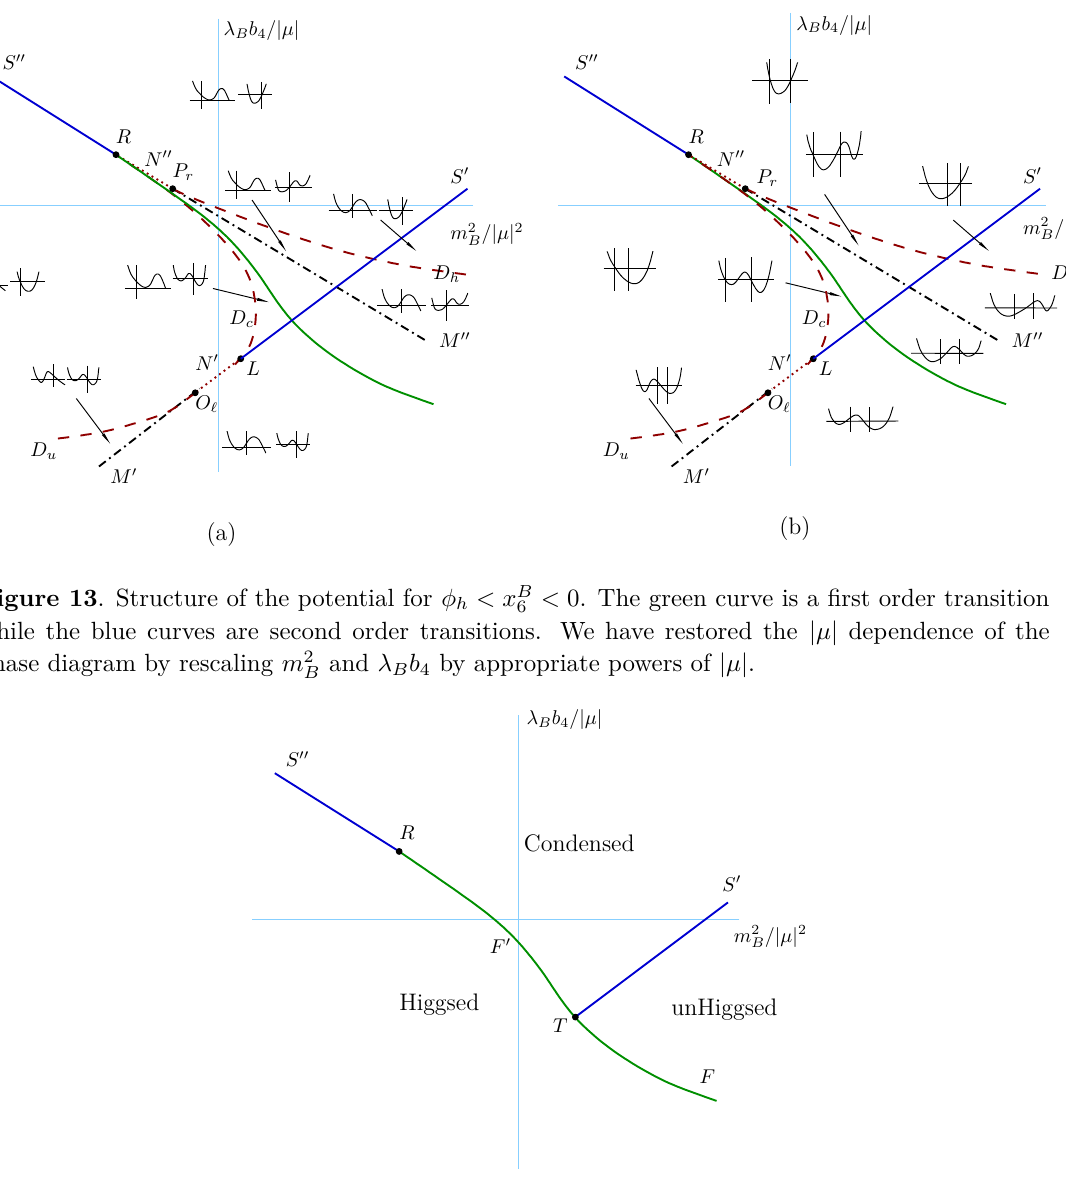
Figure 14 . Phase diagram for φ h < x B < 0 . The blue lines are second order transitions and the 6 green line is a first order transition. We have restored the | µ | dependence of the phase diagram by rescaling m 2 and λ B b 4 by appropriate powers of | µ | B